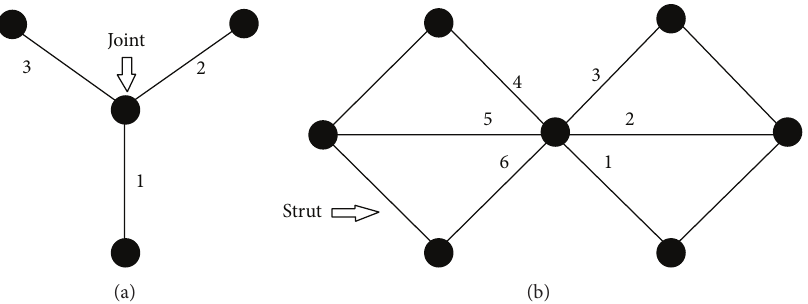
Figure 1: Cell joints and shuts. (a) A cell joint frame in honeycomb structure. (b) Triangulated frame in a grid structure.